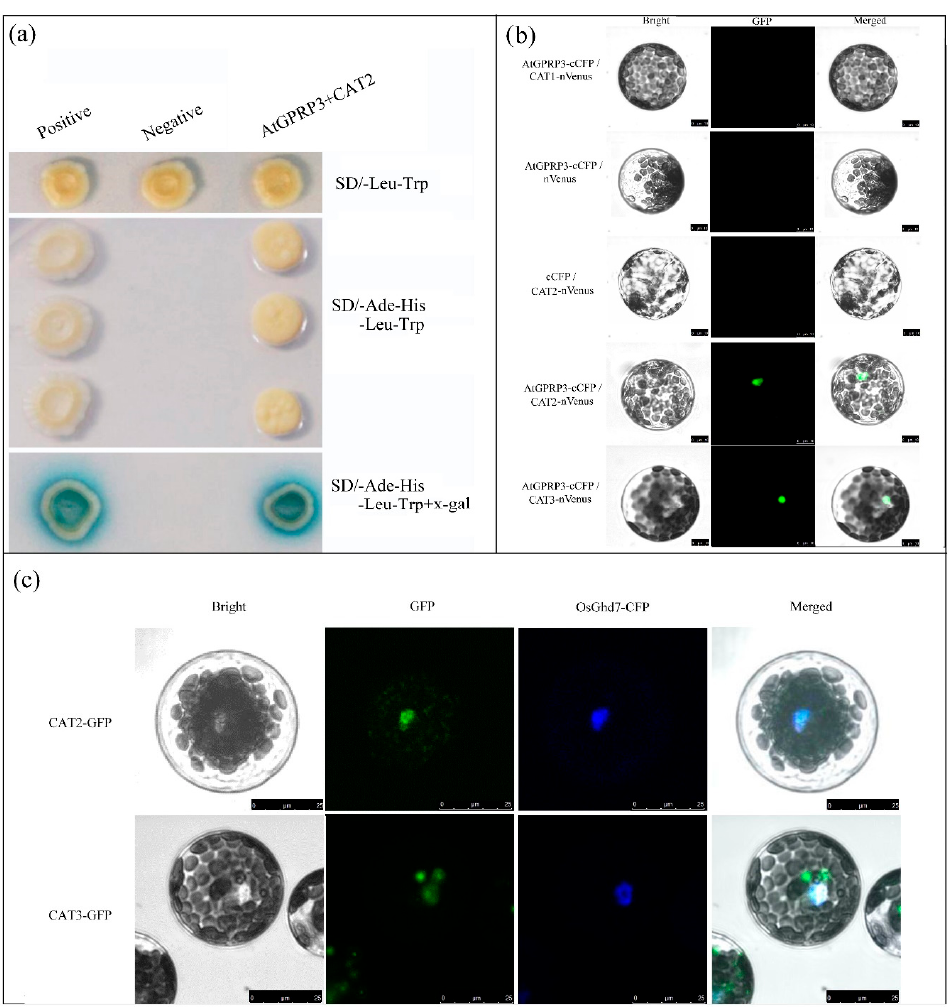
Figure 4. Interaction of AtGPRP3 with catalases and subcellular localization of CAT2 and CAT3. ( a ) Interactions of AtGPRP3 with CAT2 in yeast. Yeast transformants carrying plasmid BD53 and AD-T (positive control), empty vectors pGBKT7 and pGADT7 (negative control), and constructs of AtGPRP3 and CAT2 were cultured on selective mediums SD/-Leu/-Trp and SD/-Leu/-Trp/-His/-Ade. X-gal was used to detect the interaction of AtGPRP3 with CAT2. ( b ) Interactions of AtGPRP3 with three catalases in Arabidopsis protoplast. AtGPRP3 fused with the N-terminus of CFP was cotransformed into protoplasts, respectively, with CAT1, CAT2, and CAT3 fused with the C-terminus of CFP (cCFP) in bimolecular fluorescence complementation (BiFC) experiment. Bright, GFP, and Merged indicate bright field images, GFP fluorescence, and merged images, respectively. Bar = 10 μ m. ( c ) Subcellular localization of CAT2 and AtGPRP3 in Arabidopsis protoplast. CAT2-GFP and OsGhd7-CFP (a nuclear marker) were constitutively expressed in Arabidopsis protoplast. The GFP and CFP fluorescence images were taken from the same cell and merged. Scale bar = 25 μ m.